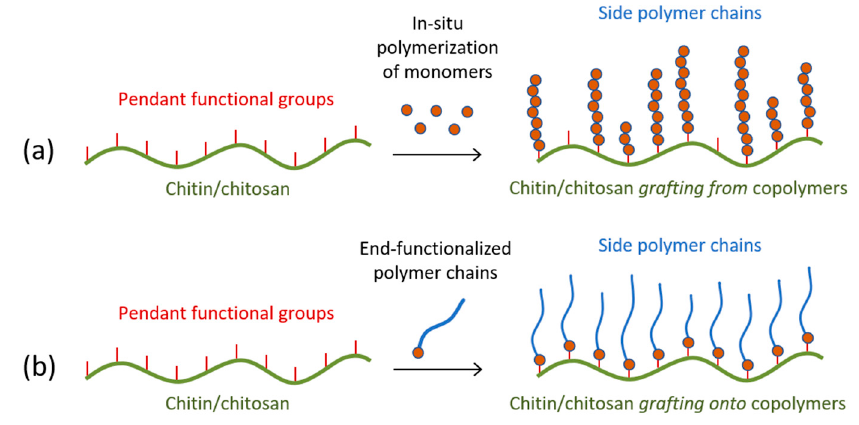
Figure 5. Schematic representation of the ( a ) grafting from and ( b ) grafting onto methods for graft copolymerization.